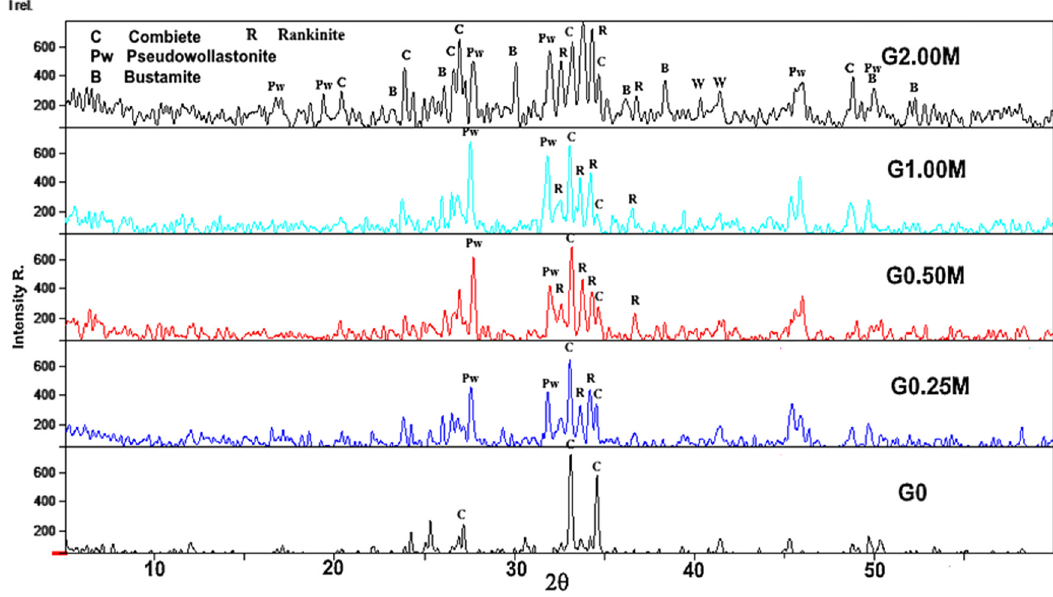
Figure 2: XRD of glasses heated at 900°C/2